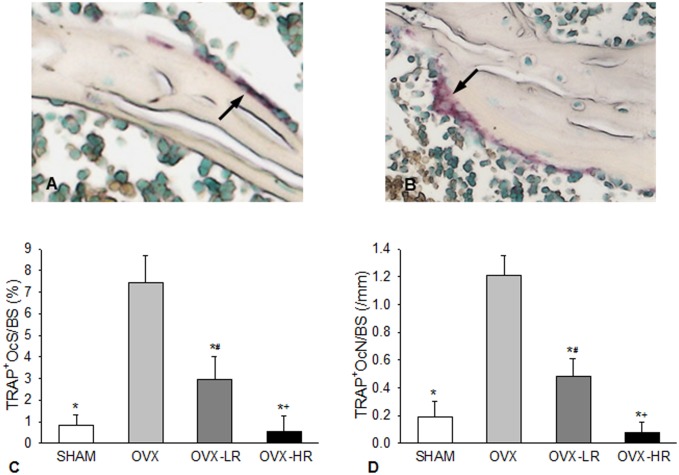
Both low and high doses of risedronate inhibit osteoclast activity resulting from estrogen depletion, but the effect is positively associated with the drug doses.A) TRAP-positive mononuclear cells on the bone surface (arrow); B) TRAP-positive multinuclear osteoclast on the bone surface (arrow); C&D) Comparison of TRAP positive osteoclast surface (TRAP+OcS/BS)(C) and TRAP positive osteoclast number (TRAP+Oc.N/BS)(D), respectively, among SHAM, OVX, OVX-LR and OVX-HR groups. *p < 0.05 versus OVX group; #p < 0.05 versus SHAM group; +p < 0.05 versus OVX-LR group. Numerical data are presented in supporting information (S2 Table).